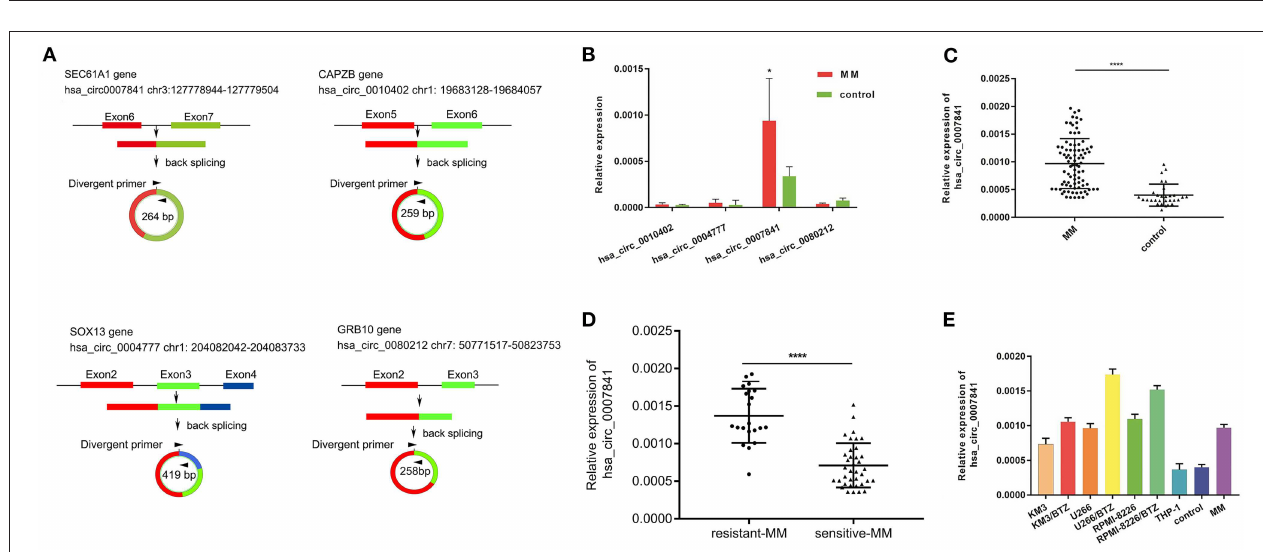
FIGURE 1 | Overview of the microarray signatures. (A) Cluster analysis diagram of differentially expressed circRNAs. (B) The block diagram represents the normalized intensity of the two groups. (C) Volcano plot showing the significantly deregulated genes in MM samples. MM, multiple myeloma.